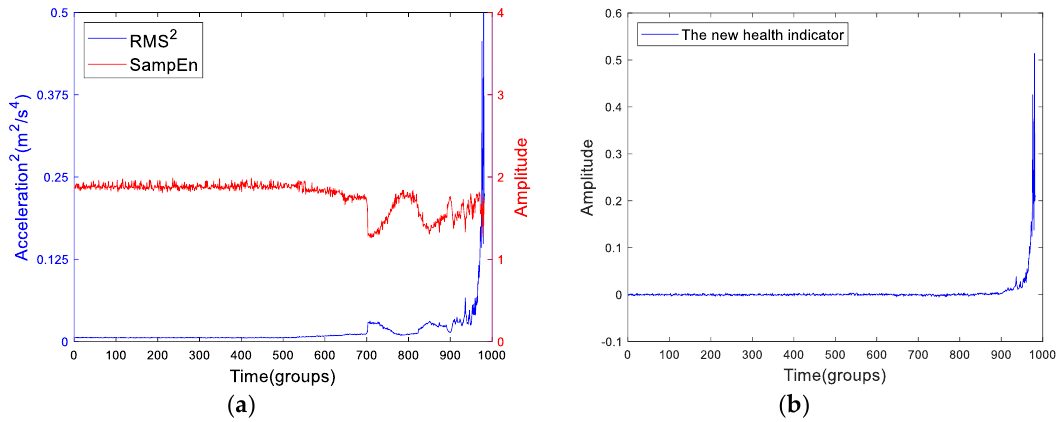
Figure 14. ( a ) The RMS 2 and SampEn curves of Bearing2-1IMS and ( b ) the new health indicator.